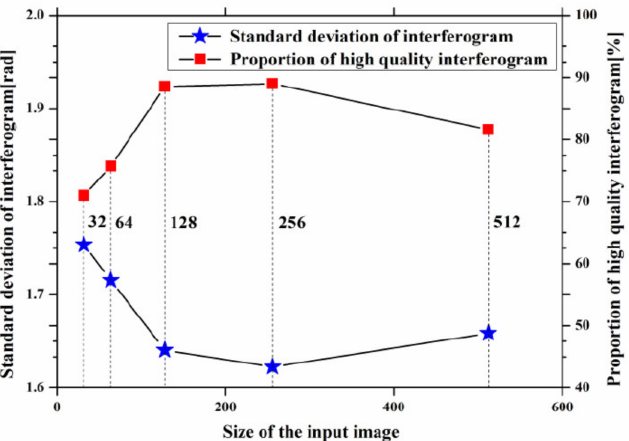
Figure 9. Training efficiency in dependency of the size of the input